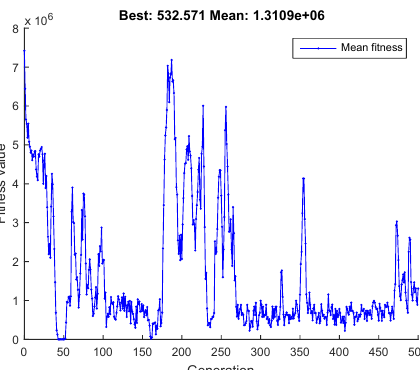
Figure 28. Suitability average in the optimization of the variables pos and pot with bar constraints. Initially f ( (cid:126) x ) = 1046.20 and at the end f ( (cid:126) x ∗ ) = 532.57 obtained with g max = 500, providing an improvement of ≈ 50% in f ( (cid:126) x ) . This produces an increase of ≈ 40% of the nodes with adequate voltage, a reduction of ≈ 30% of the nodes with precarious voltage, and a reduction of ≈ 60% of the nodes with critical voltage, when compared to the actual data, arranged in Table 7. The 10 DGPV included in the optimization process totaled 380.75 kVA of installed capacity into the grid, with a reduction in electrical losses from 13.08% to 10.72%. Figure 29 shows the voltage rating of the feeder before and after allocation of the DGPV. Figure 29b shows the reduction of points with critical and precarious voltage in the distribution power grid and Figure 30 shows the voltage profile before and after the allocation of the